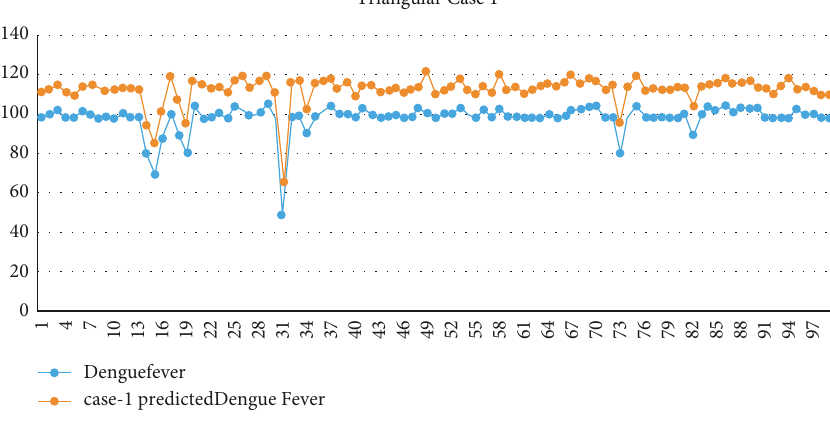
Figure 3: Fuzzy multiple regression using triangular membership